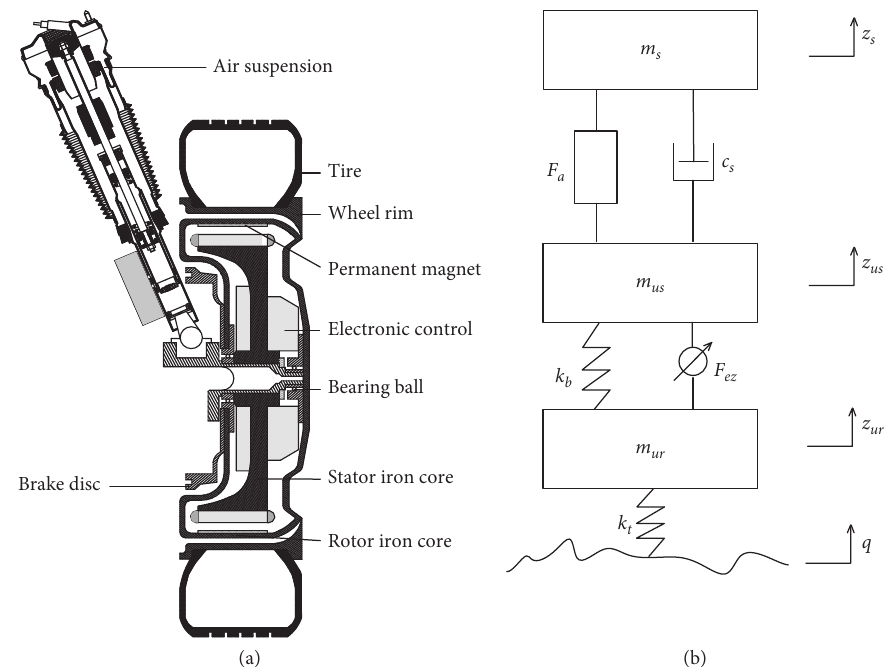
Figure 5: HDD-AS system. (a) Physical structure. (b) Equivalent model.